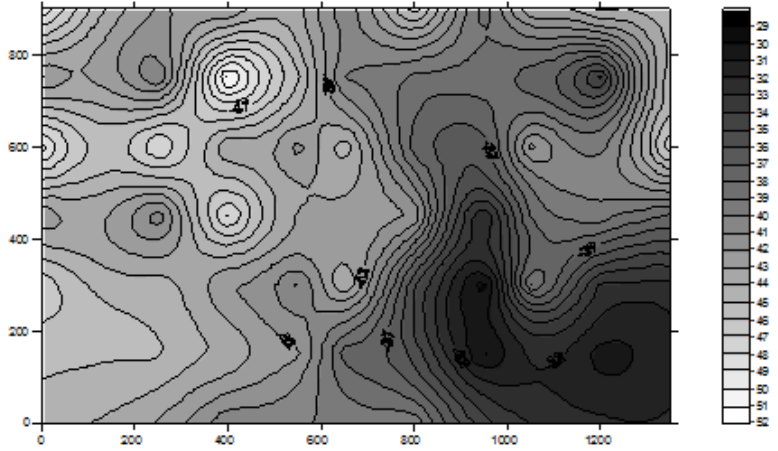
Figure 1. An example of radio map generated from a Wi-Fi signal strength